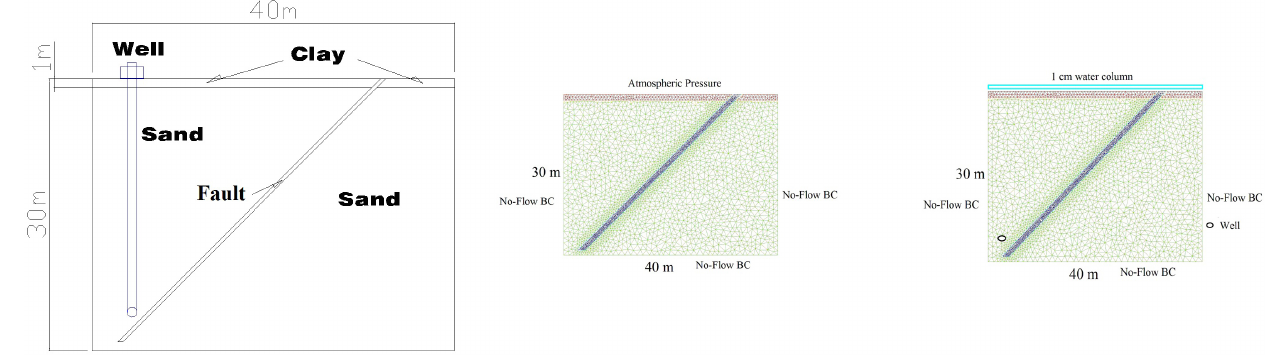
Figure 2. Idealised system (left). Unstructured grid of a 40m × 30m system with higher resolution around the fault zone (middle); Complete 1cm water column on the top boundary (right).